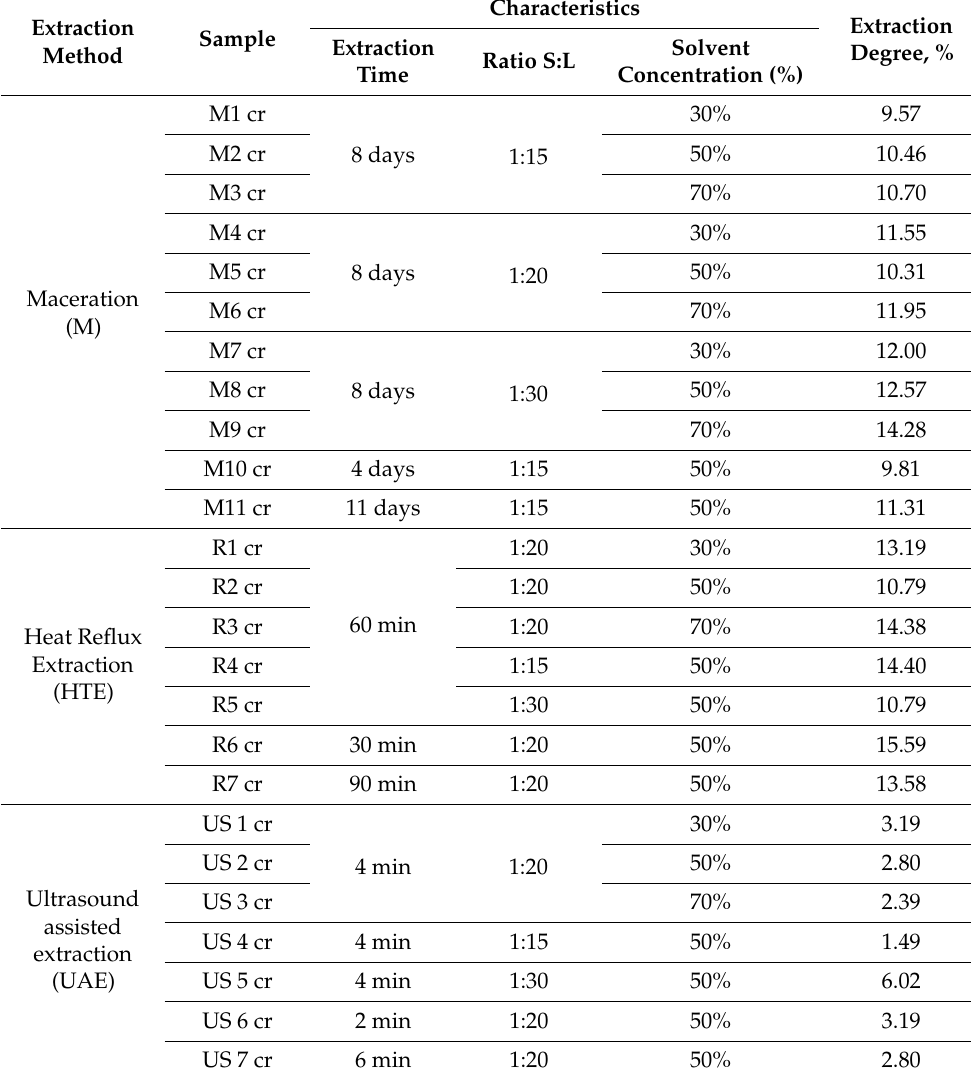
Table 2. Degree of extraction obtained in liquid-solid extraction methods used, in the case of the fresh Galium verum